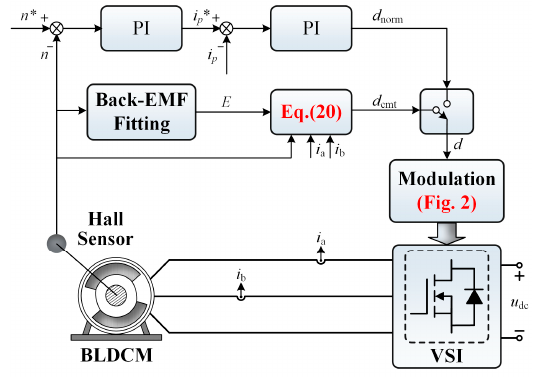
Figure 6. The control block of the proposed strategy.